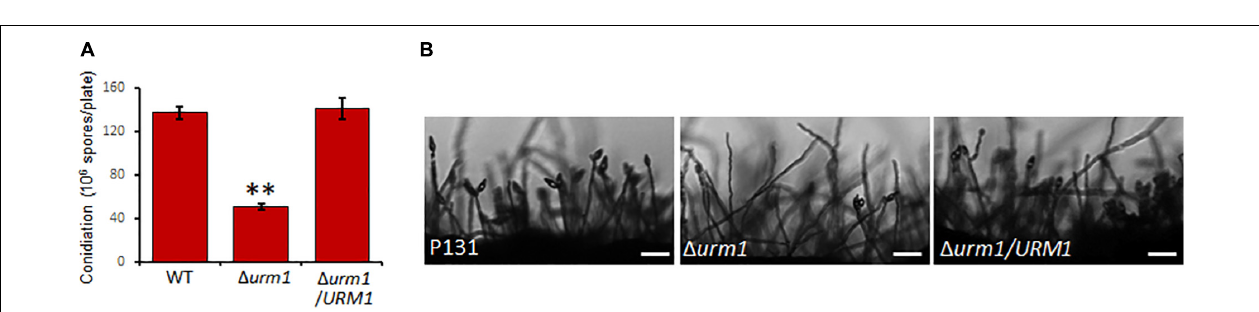
FIGURE 4 | Disruption of URM1 shows reduced conidial production. (A) Statistical analysis of conidiation of the wild type, (cid:49) urm1 mutant and complemented strains. Error bars represent the standard deviation and asterisks represent significant difference among strains ( P < 0.01). (B) Conidial and conidiophore formation were observed under a light microscope. The indicated strains were grown on OTA plates for 5 days. Bar, 50 µ